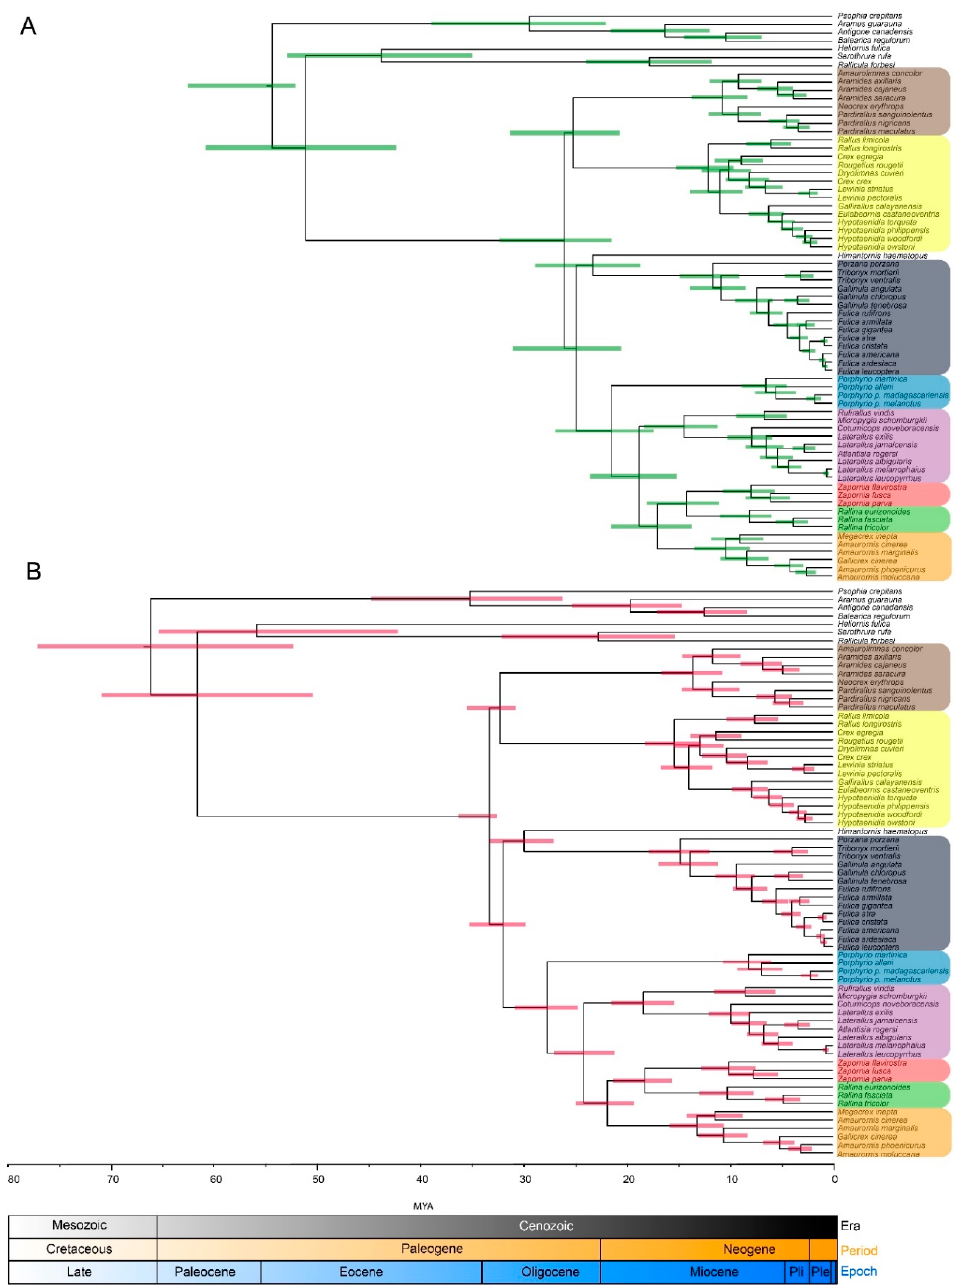
around 19 (16 ‒ 23) Mya and 34 Mya (32 ‒ 44) for the crown Ralloidea and Rallidae calibrations, respectively.